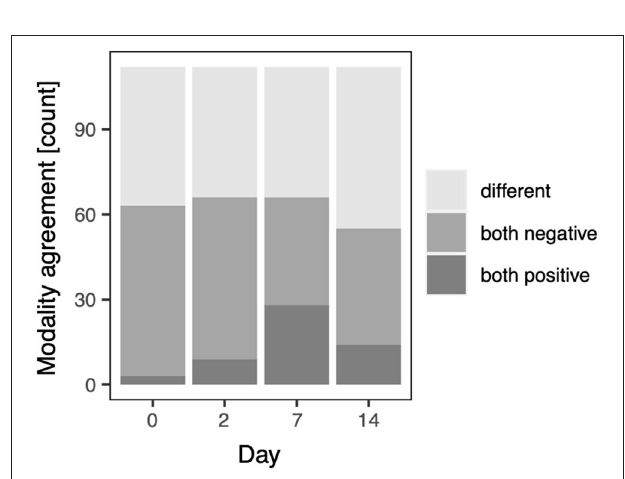
FIGURE 4 | Modality agreement for the qualitative scores on the study days; pre-infection (D0), D2, D7, and D14, respectively.